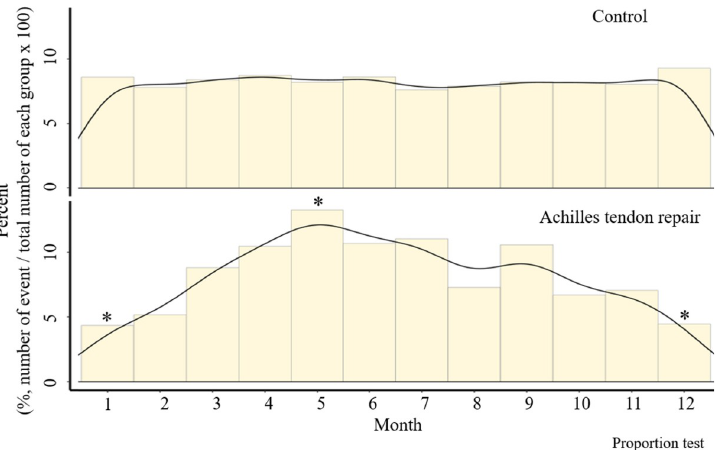
Fig 3. Monthly distribution of occurrences in control and Achilles tendon repair (ATR) groups (2002–2015). Incidence of ATR peaks in May, fewer injuries occurring in December and January.